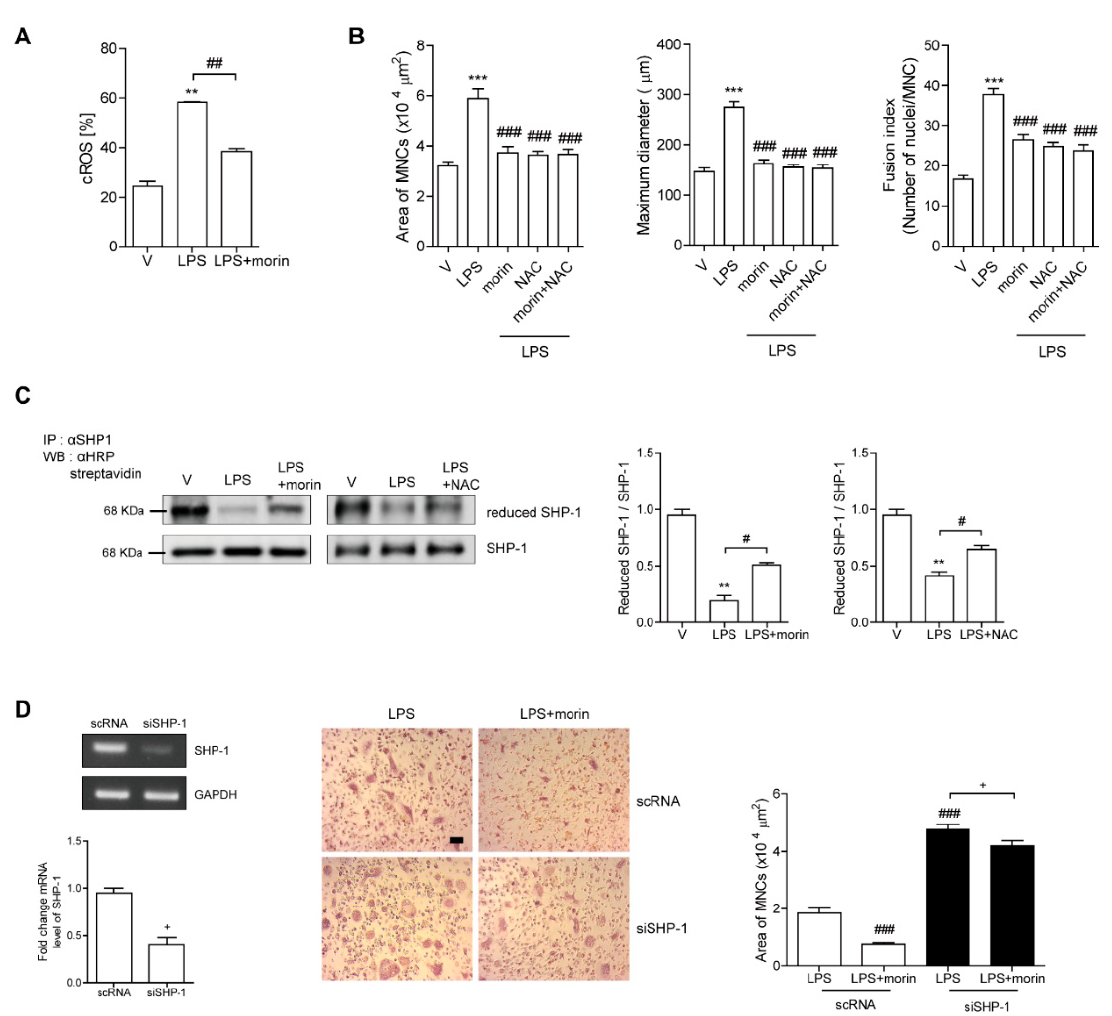
Figure 5. Morin decreases LPS-induced oxidation of SHP-1 to attenuate c-Src activation by decreasing the ROS level in OCs. ( A ) BMMs were cultured with M-CSF (30 ng/mL) and RANKL (40 ng/mL) for 96 h. Cells were washed with PBS and stimulated with LPS (50 ng/mL) ± morin (200 μ M) in the presence of M-CSF (30 ng/mL). Cytosolic ROS were determined after 6 h exposure of LPS ± morin (200 μ M) in the presence of M-CSF by flow cytometry using H 2 DCF-DA (B-D). Cells were incubated with M-CSF (30 ng/mL) and RANKL (40 ng/mL) for 40 h, and then further stimulated with M-CSF and LPS (50 ng/mL) ± morin (200 μ M) or NAC (3 mM) for 48 h. More than 70 TRAP-positive MNCs randomly selected, and the surface area, maximum diameter, and fusion index of OCs were plotted ( B ). Immunoprecipitation (IP) with anti-SHP1 was performed after labeling the cell lysate with N - (biotinoyl)- N ′ -(iodoacetyl) ethylenediamine (BIAM), followed by immunoblotting with HRP- streptavidin to identify the reduced form of SHP1 as shown ( C ). The cells were transfected with scRNA or siSHP1 and incubated further with LPS (50 ng/mL) ± morin (200 µ M) in the presence of M-CSF (30 ng/mL) for 48 h. The downregulation of SHP-1 by siRNA was confirmed by RT-PCR and qPCR. The cells were fixed, and the surface area of the OCs was measured ( D ). Representative photos are shown. Scale bar: 100 µ m. ** p < 0.001, *** p < 0.001 compared with vehicle; # p < 0.05, ## p < 0.01, ### p < 0.001 compared with LPS-treated cells; + p < 0.05 compared with each corresponding control. Similar results were obtained from three independent experiments. Given that SHP-1 is a nonreceptor-type protein tyrosine phosphatase that may de- crease c-Src (Y416) phosphorylation [35], and that our previous studies demonstrated a direct interaction between c-Src and SHP-1 upon ROS stimulation [36], we